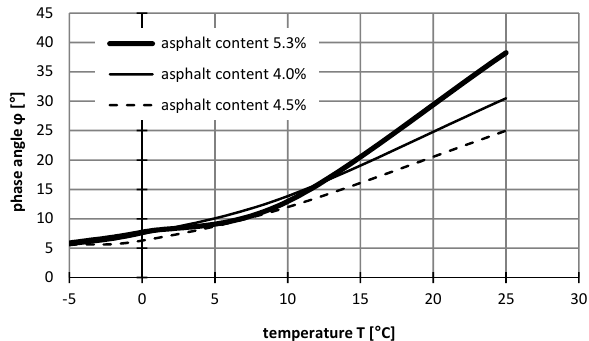
Figure 13. The relationship between the phase angle and temperature.